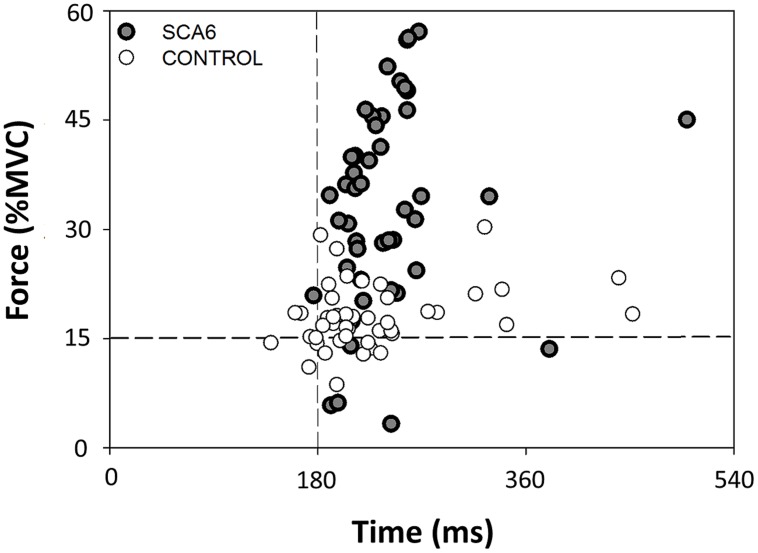
Representative end-points of the 50 trials during the goal-directed task for a SCA6 and an age-matched control participant relative to the target. The SCA6 participant exhibited greater force dysmetria than the control participant.